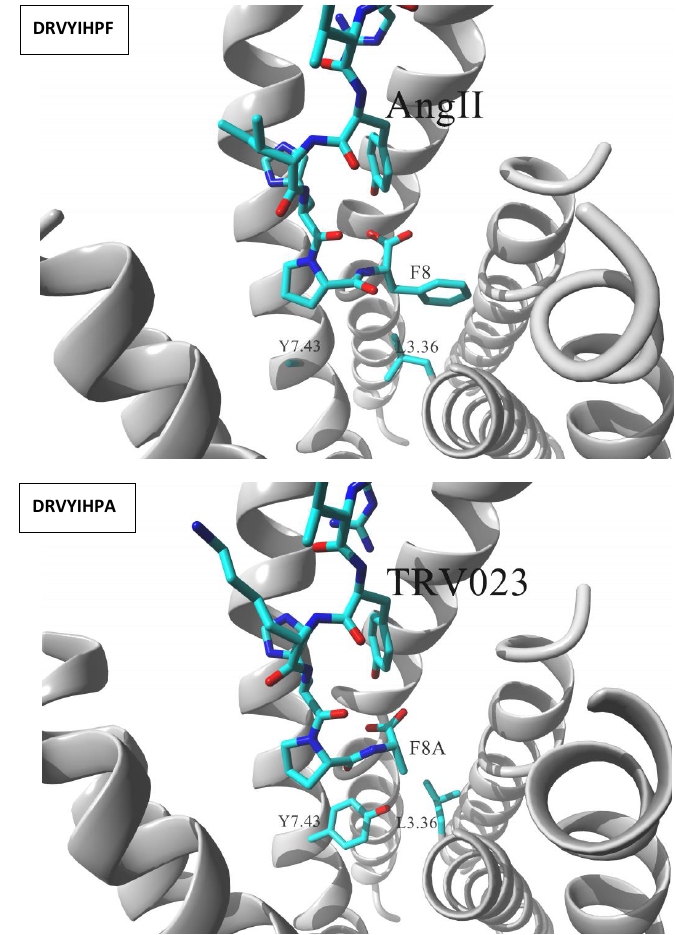
Figure 4. AT 1 receptor cocrystalized with (A ) wild type AngII peptide (6os0.pdb) (G q + β-arrestin signaling) and ( B ) F8A AngII mutant (TRV023; 6os1.pdb) (β-arrestin biased signaling). Due to high B-factor, conformation of the Y292 7.43 cannot be fully visualized in ( A ) [58]. The receptor is shown in secondary structure mode (gray ribbon), parts are hidden for clarity. Ligand molecules, L112 3.36 and Y292 7.43 residues are rendered in stick mode. Inset: sequence of cocrystalized pep- tide.